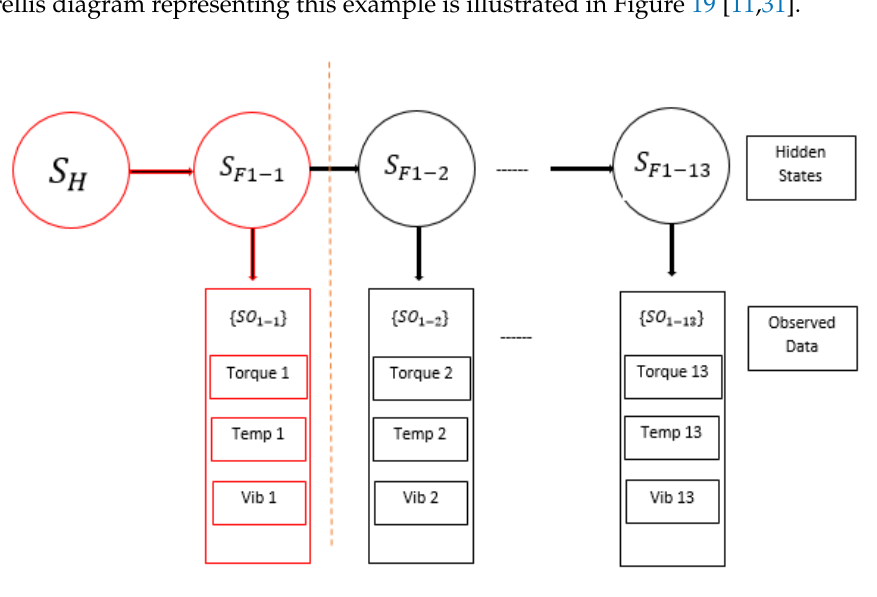
Figure 19. Trellis diagram example.